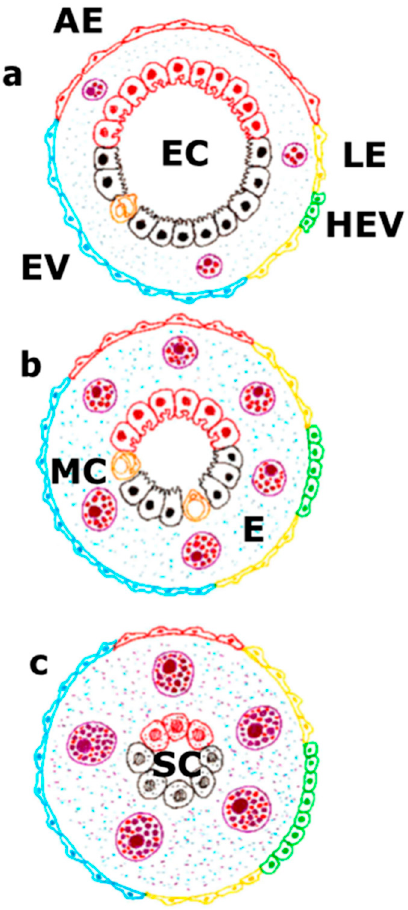
Figure 2. The vascular endothelium takes part either in the physiological situation ( a ), in the splanchnic inflammatory response related to portal hypertension ( b ) or in the portal hypertension associated with chronic liver disease ( c ). In the physiological situation, a balance between the extent of the arterial endothelium, venous endothelium, including high endothelial venules, and lymphatic endothelium exists. This fact is associated with the presence of a specialized hepato-intestinal epithelium. In this case, the mast cells would make a basic function of maintaining this endothelium-epithelium coupling. On the contrary, during the progressive development of portal hypertension, the splanchnic mast cell number increases. Due to their inflammatory activation, they cause progressive interstitial